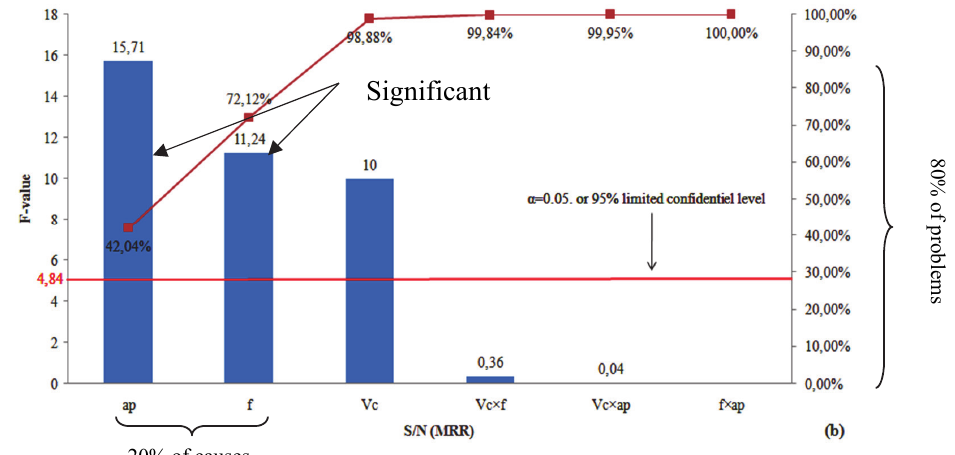
Fig. 4. Pareto analysis chart, for effect of machining parameters on: (a) surface roughness and (b) material removal rate.